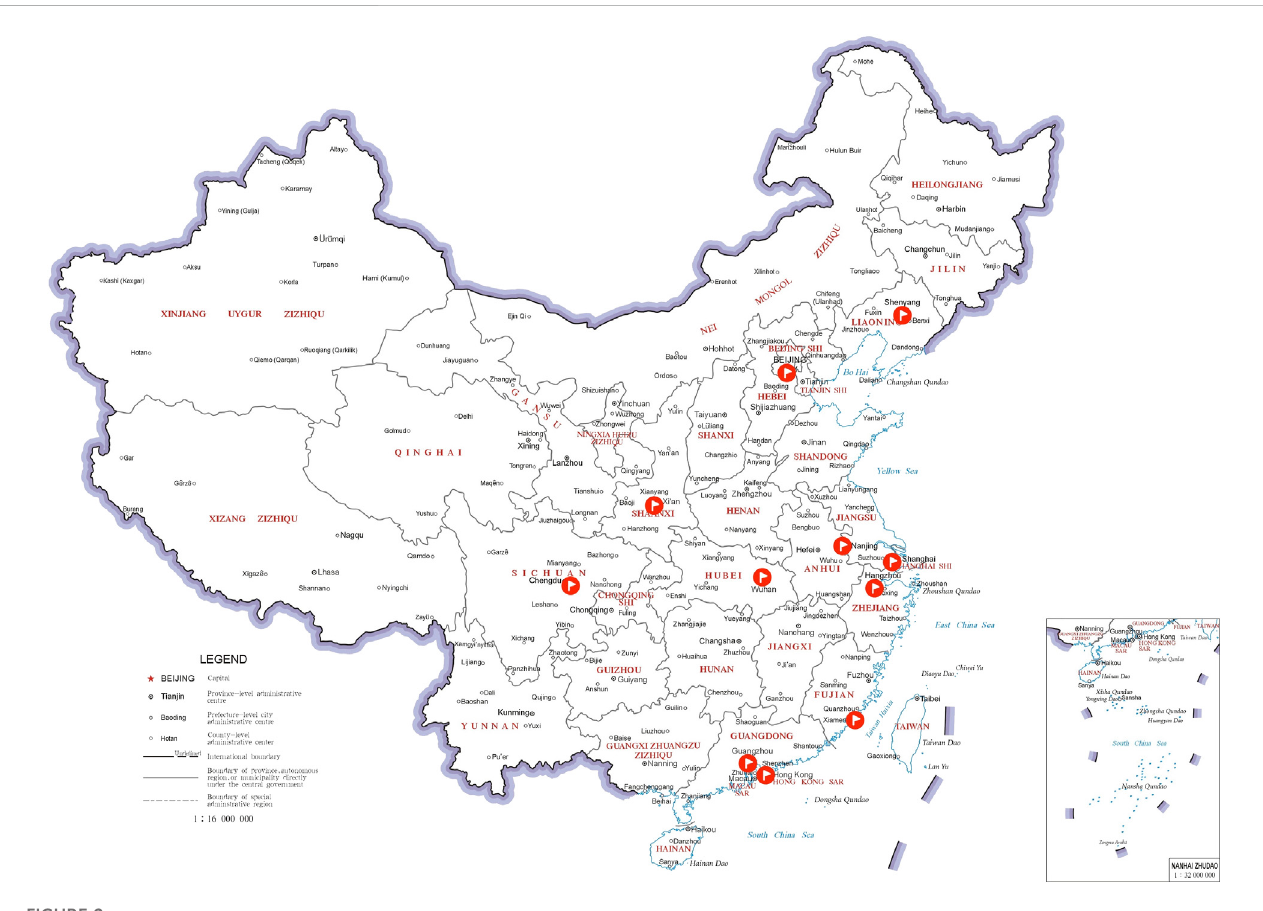
FIGURE 2 Geographical location of MSWSM policy source city in